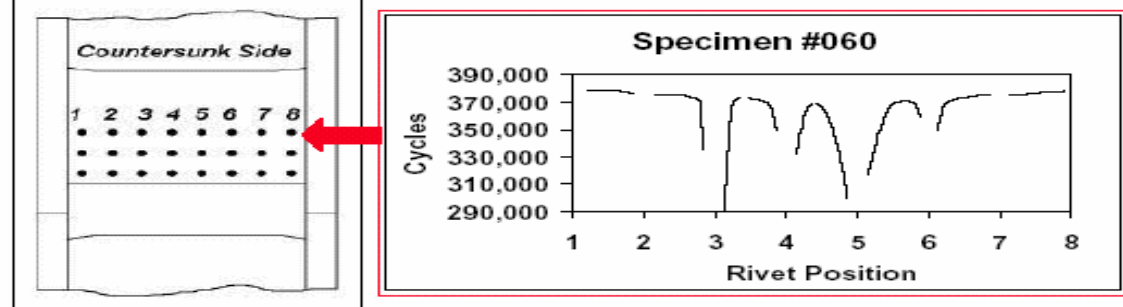
Fig 4. Typical MSD growth pattern in a non-corroded